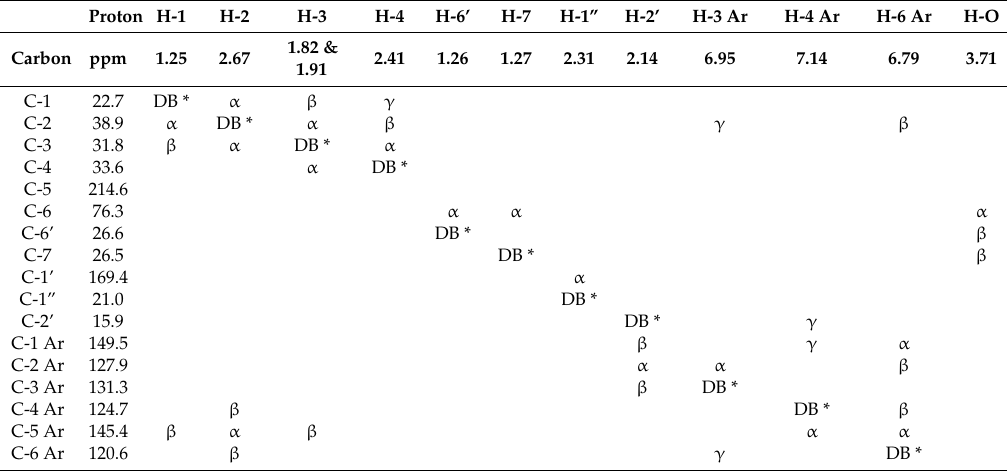
Table 1. HMBC Correlations for the title compound 2